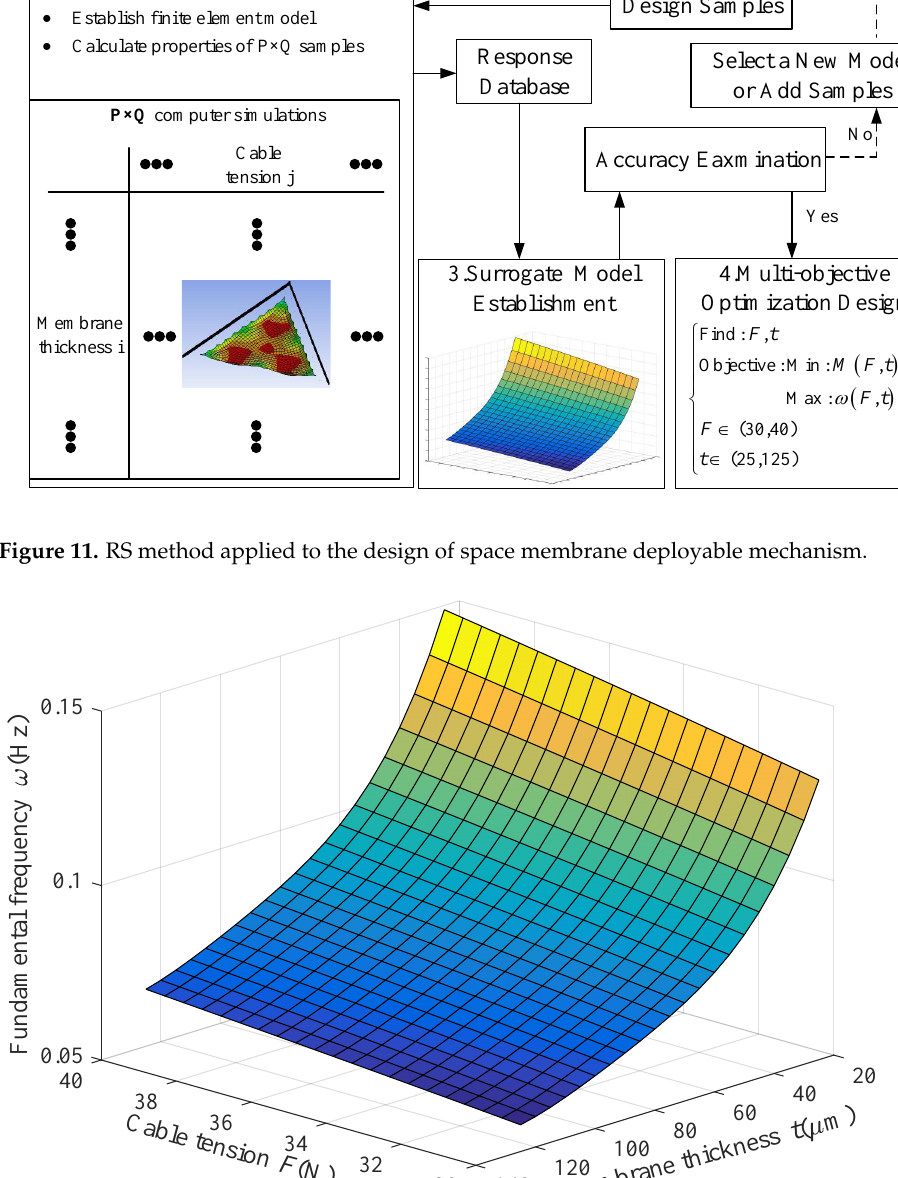
Figure 12. Response surface of the dynamic characteristic for the membrane